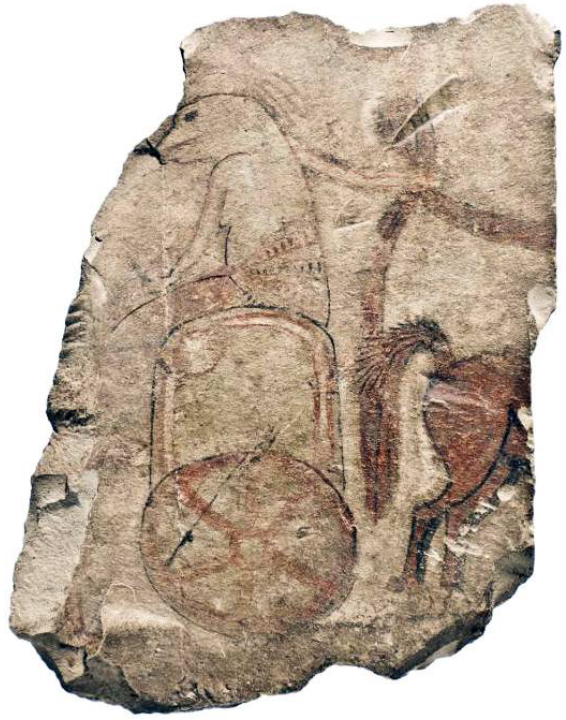
Figure 5. Mouse riding chariot (MM inv. no. 14049), limestone flame, Deir el-Medina, Ramesside period (Image courtesy of the Medelhavsmuseet, Stockholm).